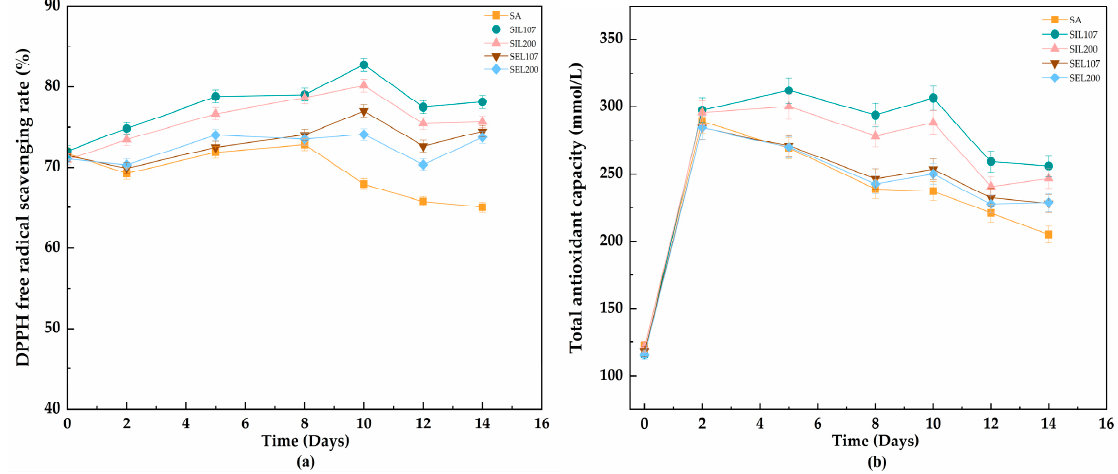
Figure 3. Dynamic evolution of the DPPH free radical scavenging rate ( a ) and total antioxidant capacity ( b ) during the fermentation of ciders.